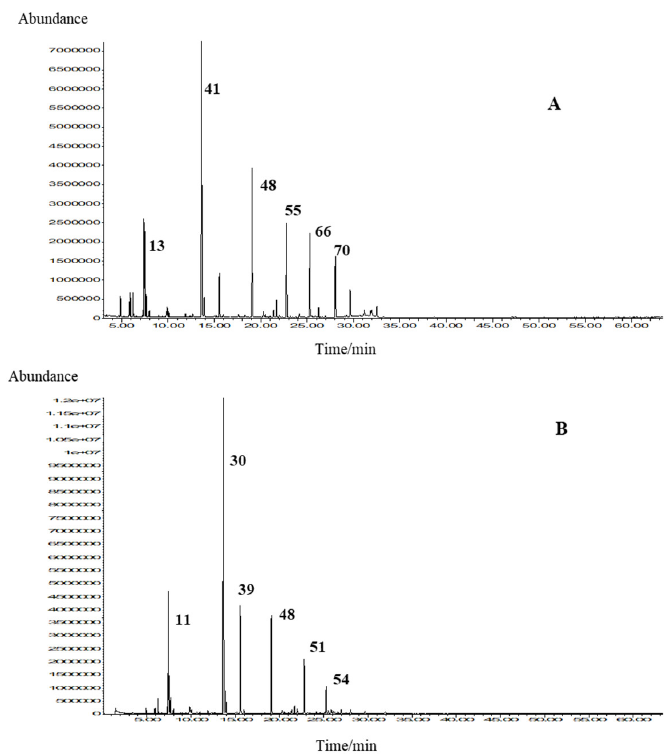
Figure 2. Total ion chromatograms (TICs) of the headspace ( A ) and essential oil ( B ) of Mentha dulcia citreus Hillary’s Sweet Lemon ( M5 ). The numbers in ( A ) correspond to the compounds in Table 2, and the numbers on ( B ) correspond to Table 1.